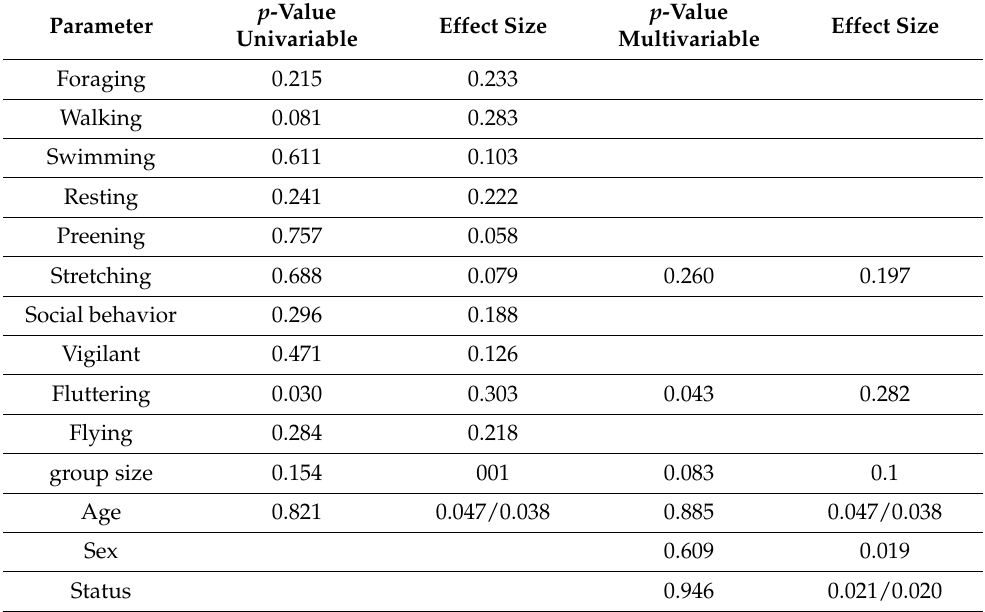
Table 4. The p -values of the univariable and multivariable